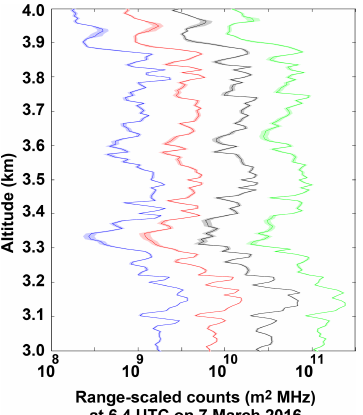
Figure 2. Selected profiles of range-scaled 532nm photocounts as a function of altitude for four consecutive minutes just after 06:40UTC on 7 March 2016 (same date as for Fig. 1), each offset by 1 × 10 0 . 6 (or 4m 2 MHz) along the x axis, between the altitudes of 3 to 4km. Shaded areas show uncertainty. There are clearly hor- izontal coherent structures in the cloud in space (aliased to time by motion over the lidar) at least down to the 7.5m height resolution of the